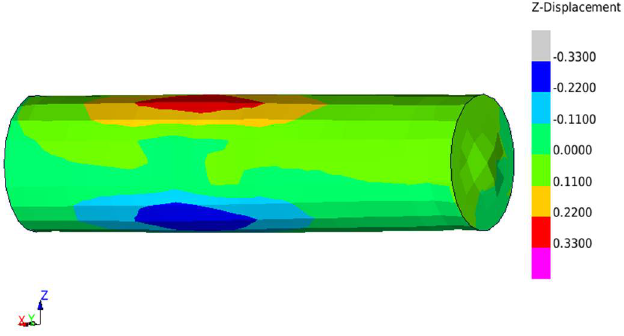
Figure 15. Simulation of the battery deformation on impact direction.